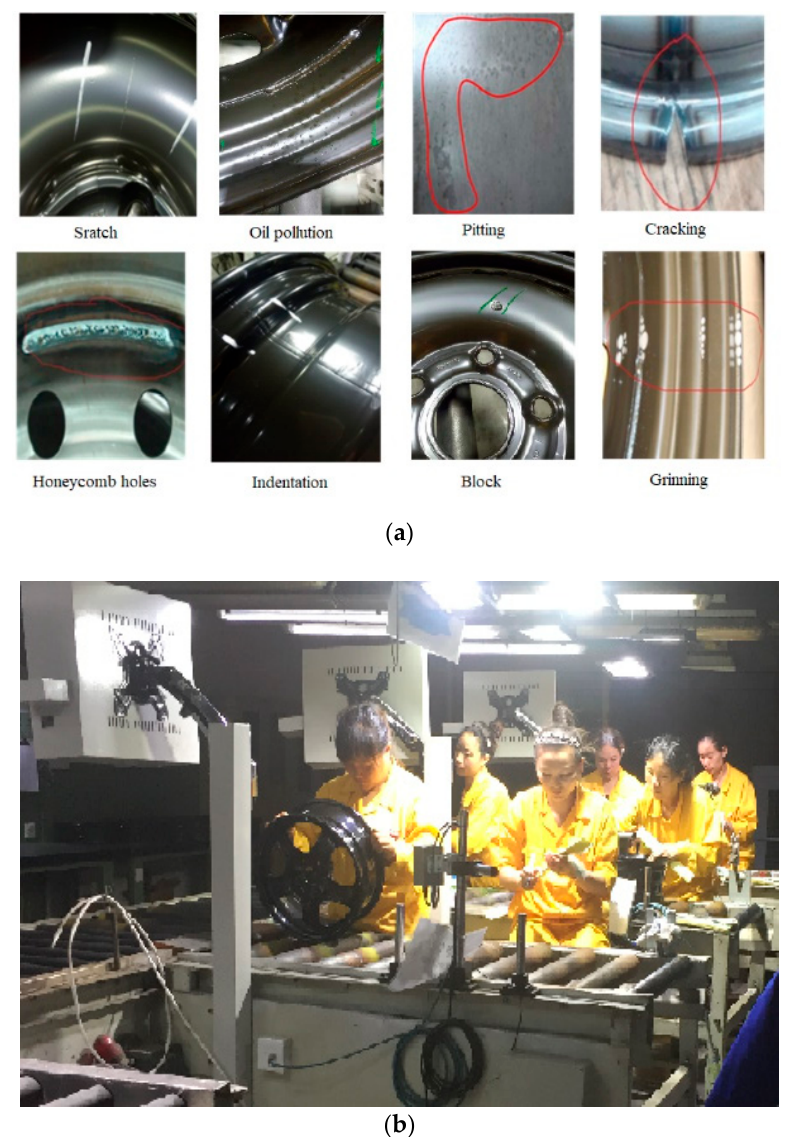
Figure 1. Wheel hub inspection: ( a ) common defects; ( b ) manual detection process.